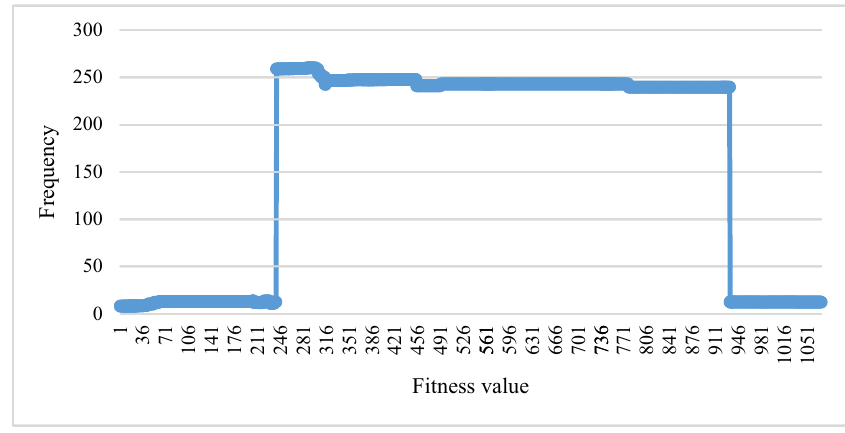
Figure 10: The fi tness values of the BA.